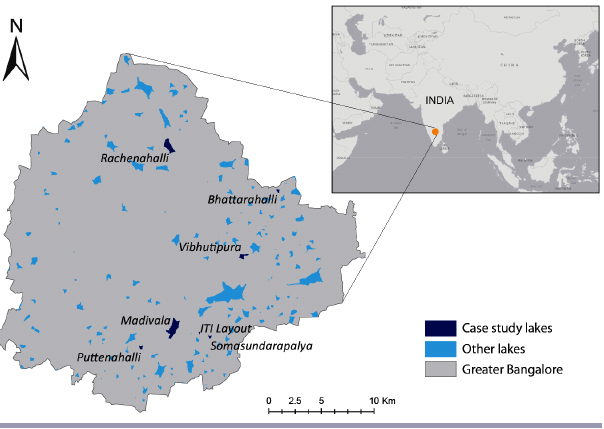
Fig. 1 . Map of Bangalore, India, its lakes, and the selected case study